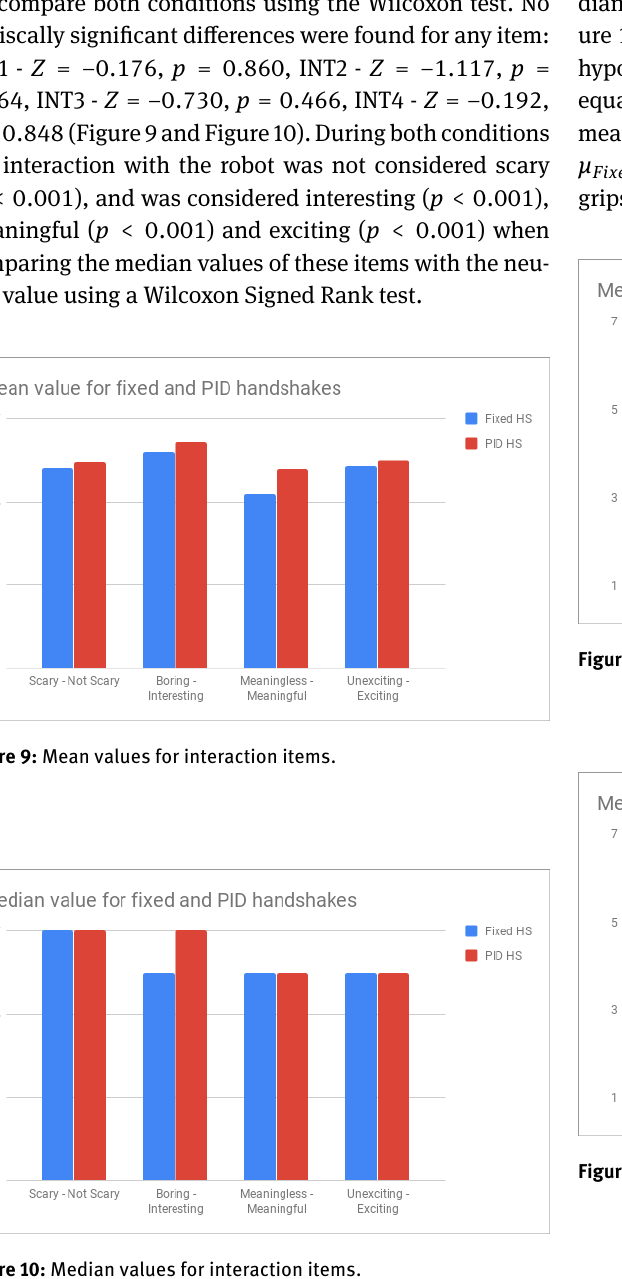
Figure 10: Median values for interaction items.